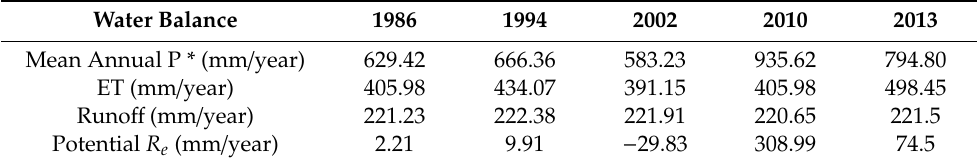
Table 10. Water balance in Alto Atoyac sub-basin from the climate record.